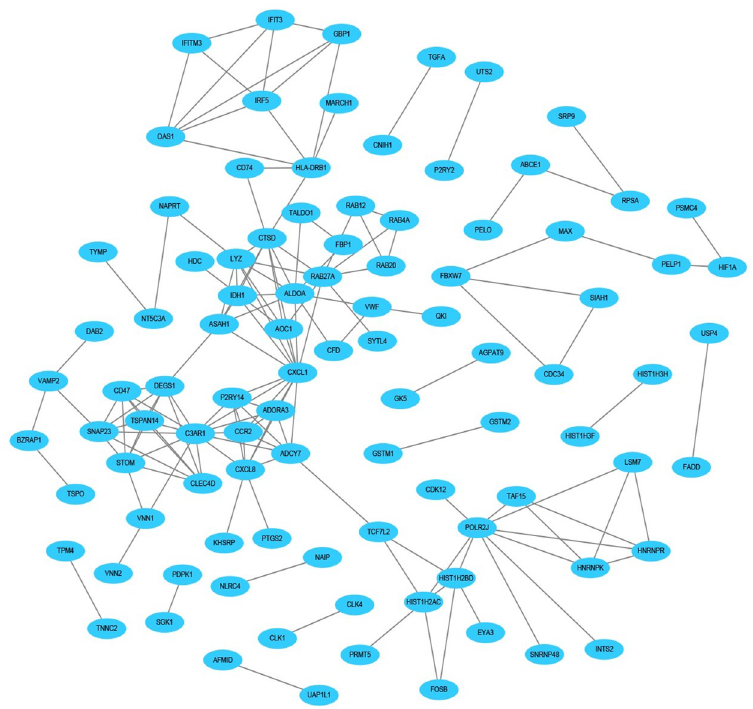
Fig 5. Male-specific PPI network in epilepsy. The PPI network included 96 nodes and 151 edges.